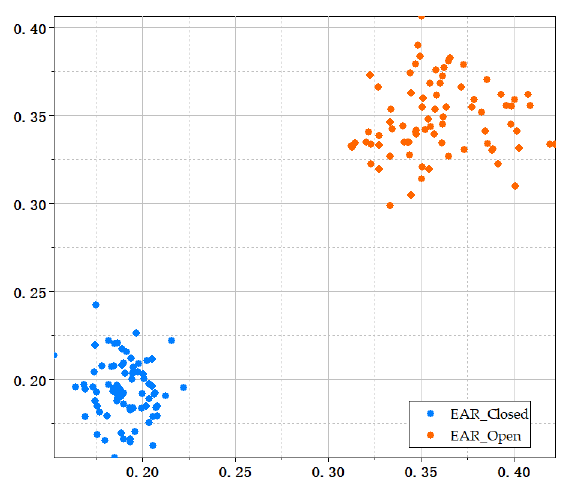
Figure 7. Difference between EAR when eyes are open and closed .